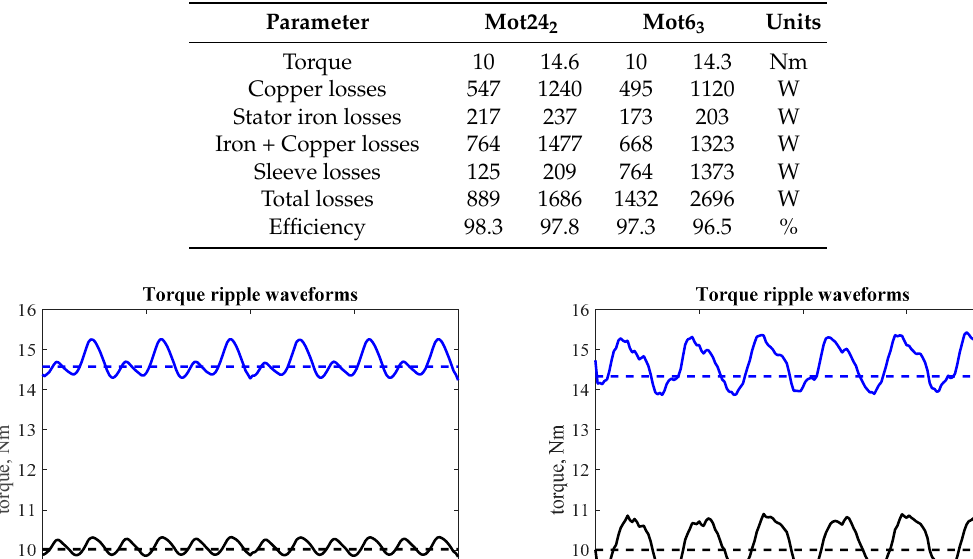
Table 3. Losses and efficiency of the selected optimized machines at rated and overloaded conditions.